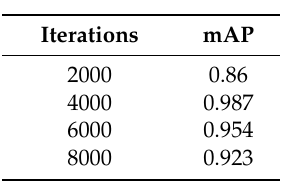
Table 8. Iteration number test